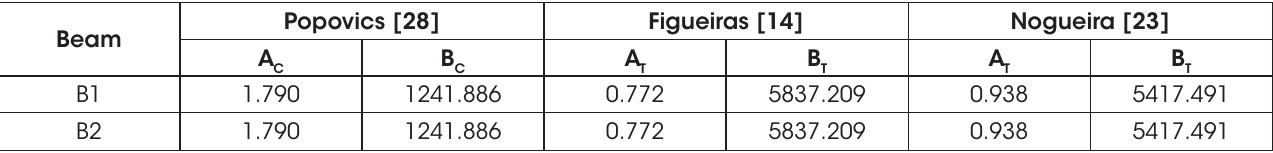
Damage parameters adopted for concrete